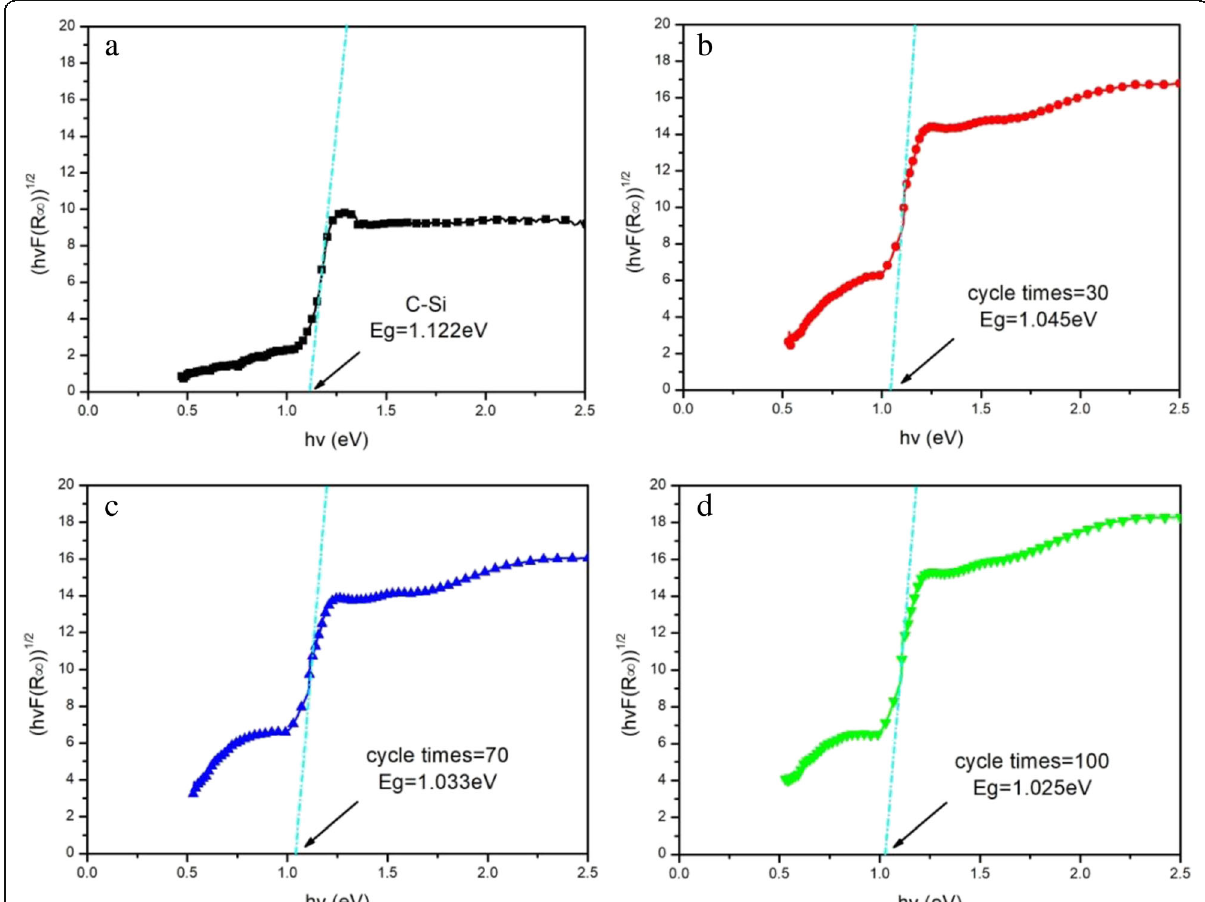
Fig. 7 Band gaps of C-Si ( a ) and black silicon made by different cycle times: ( b ) 30, ( c ) 70, ( d )